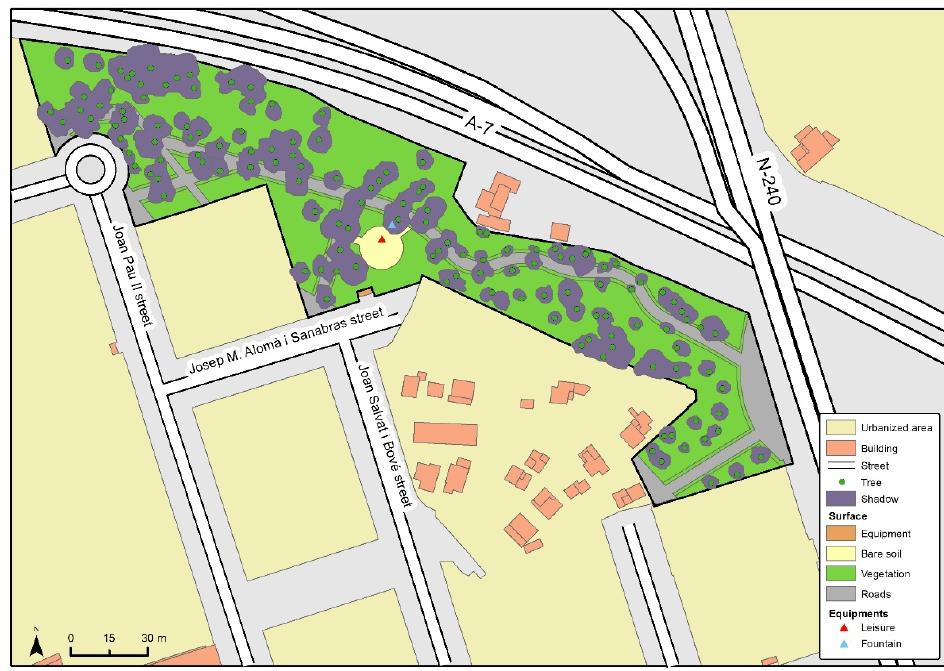
Figure 3. Example of the mapping database of the Fitolaca park (Tarragona). Source: own work .